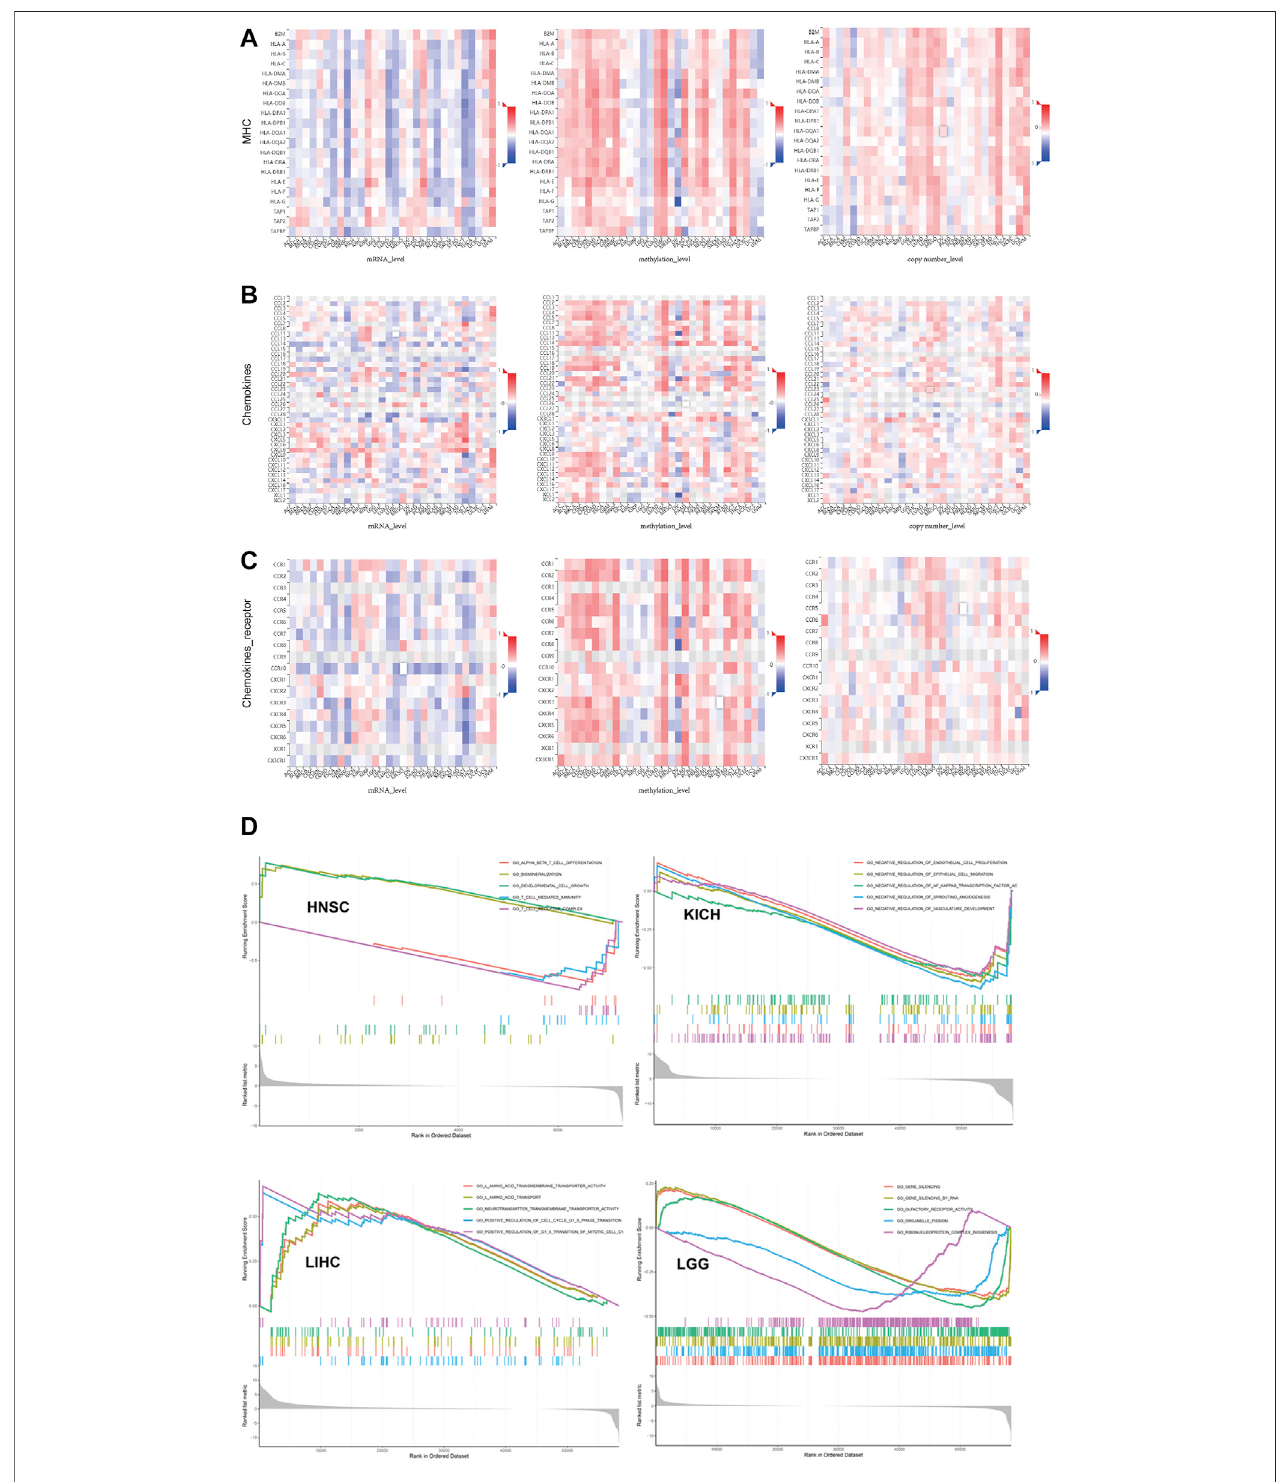
FIGURE3| Multi-omicsdatashowedSLC7A11expressionwasbroadlyassociatedwithimmunebiomarkersbutwithtumorspeci fi city. (A) MHC. (B) Chemokines. (C) Chemokine receptor. (D) GSEA to investigate which signal pathways were altered along with differential expression of SLC7A11 in cancers whose prognosis was associated with